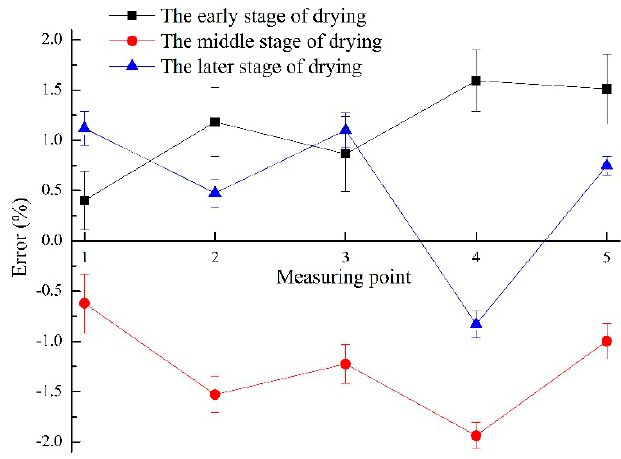
Figure 9. Error analysis of stratified moisture content prediction.